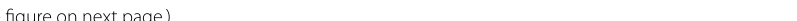
annually(See figure on next Fig. 3 Personnel of PICUs in the “D–A–CH” region. The web diagram ( a ) displays the percentage (of valid responses) of PICUs meeting the recommendations for the different items surveyed. In the table ( b ), the valid response rates for the different items are listed. The bar charts ( c ) display the mean of all 14 items concerning personnel according to the sub-categories university/non-university hospital and treated